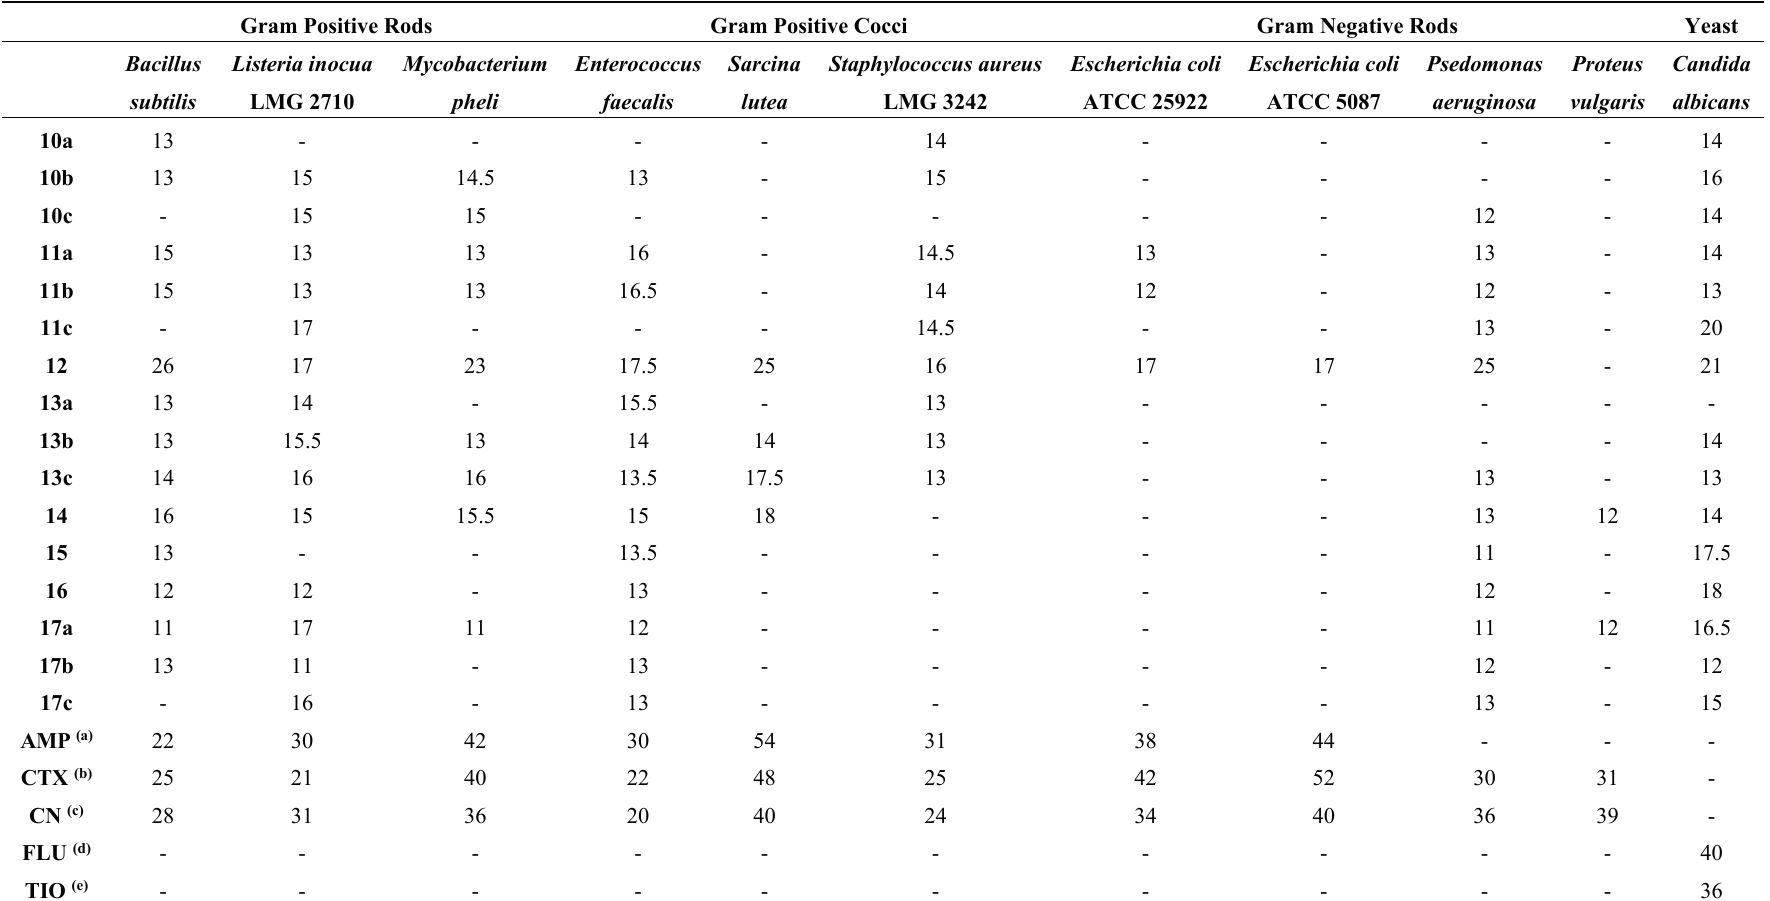
Table 1. The zone of inhibition (mm) for test compounds * #